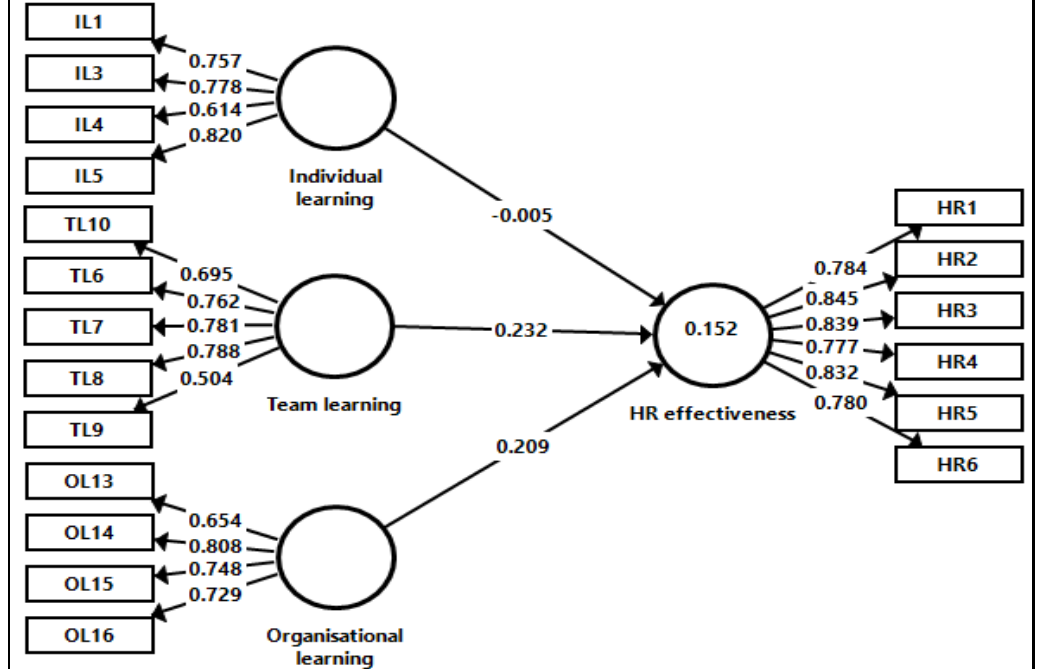
Fig. 2. Learning dimensions and HR